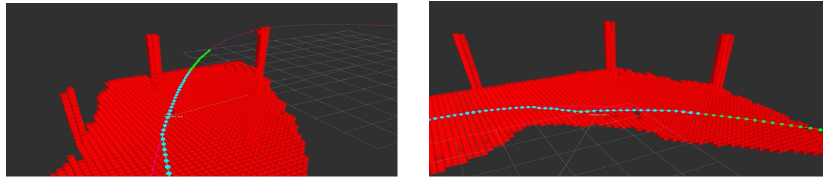
Figure 7. Occupancy grid (red), local trajectory (green), and global trajectory